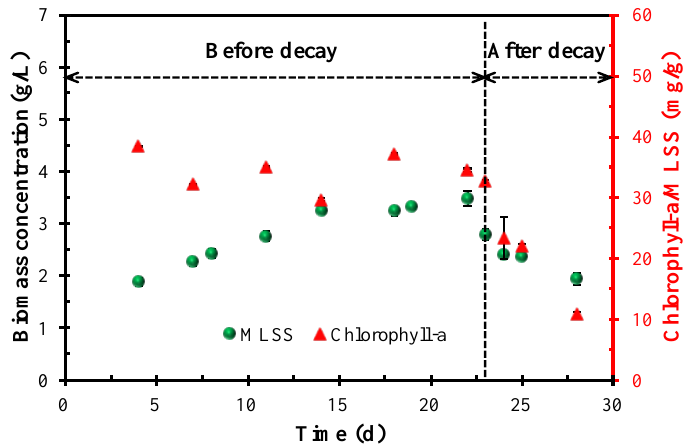
Figure 2. Variation in biomass concentration and chlorophyll-a/MLSS in the MPBR.